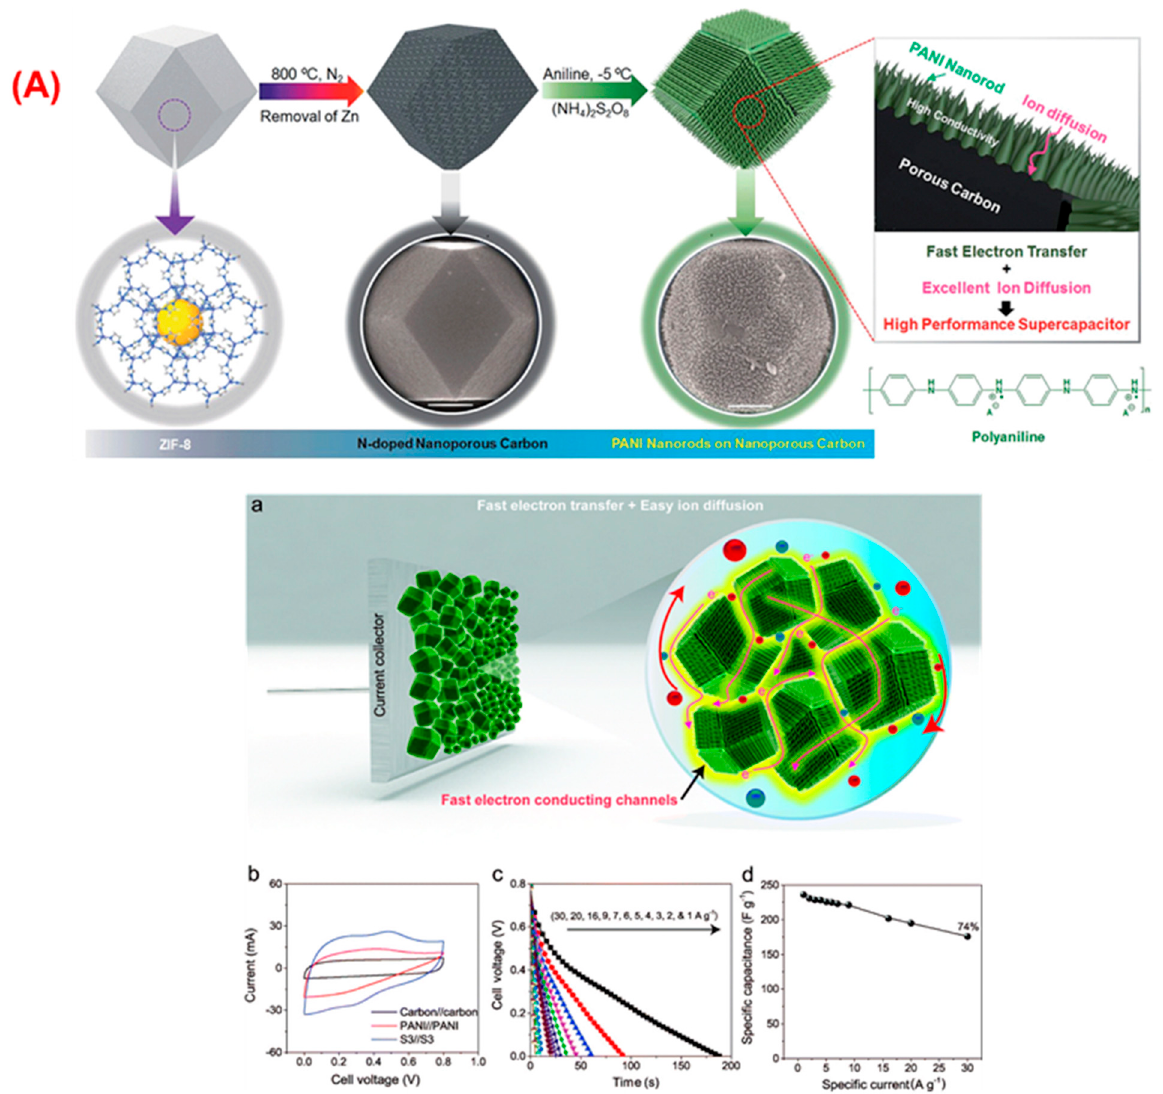
Figure 4. ( A ) Schematic illustration and preparation methodology of the nanoporous carbon/PANI core–shell nanocomposites from the ZIF-8; electrochemical performances, ( a ) distinctive multifaced nanoarchitecture avoids the general issue of stacking caused by one-dimensional CNTs or two- dimensional graphene, which allows ions to penetrate deeper into the material more easily; ( b ) CVs of carbon//carbon, PANI//PANI and carbon–PANI//carbon–PANI (S3), capacitors in 1 M H 2 SO 4 electrolyte. ( c ) Discharge profile for the S3 capacitor at various current densities; ( d ) plot of specific capacitance vs. current density. Reproduced from